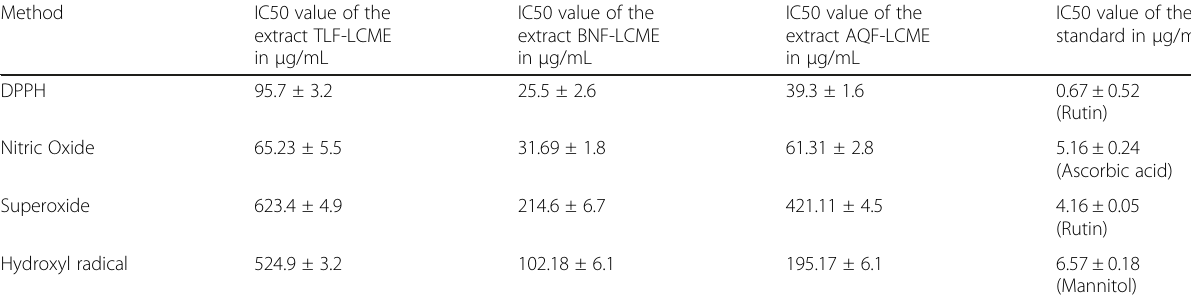
Table 2 In vitro antioxidant activity of fractions of LCME and their corresponding standards Method